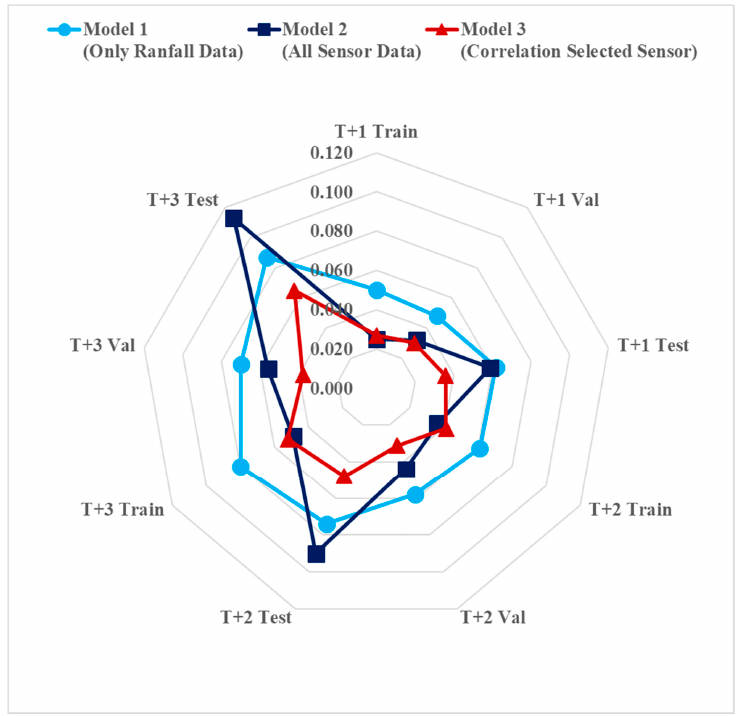
Figure 9. The radar chart of models’ performance (RMSE) in three phases.